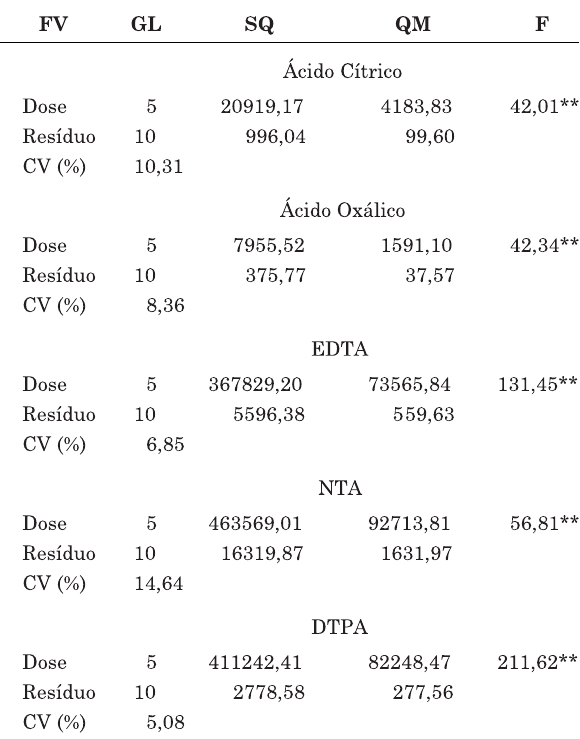
Quadro 2. Análise de variância das doses dos quelantes (ácido cítrico, ácido oxálico,